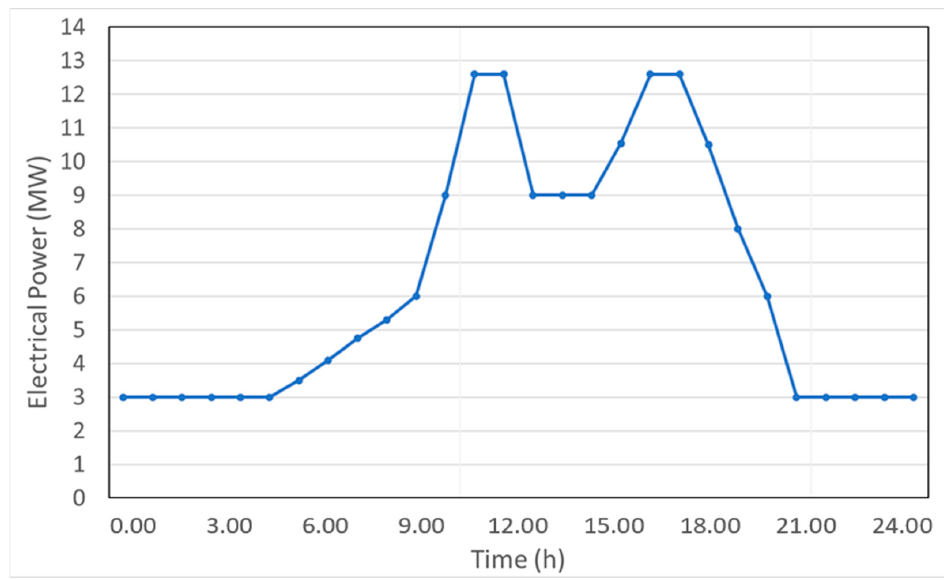
Figure 3. Port Electrical Loads (Hourly Profile).